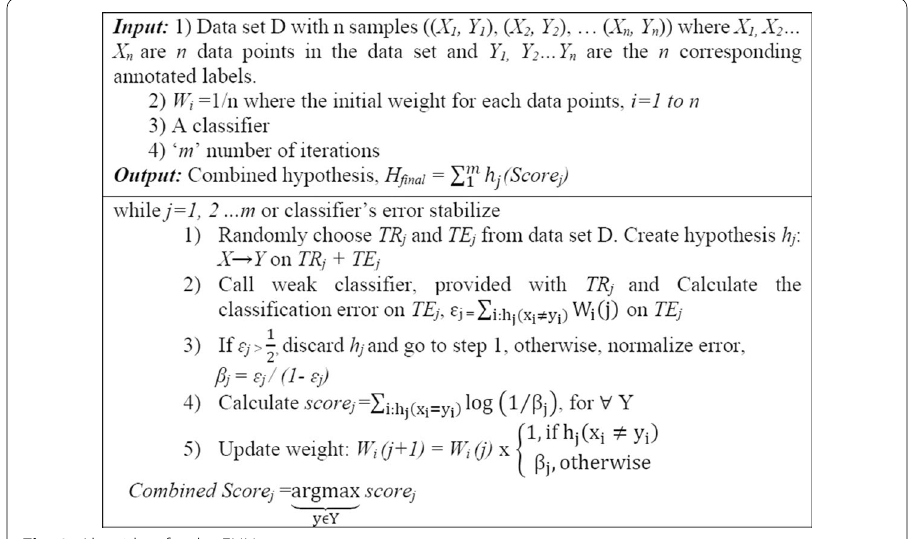
Fig. 2 Algorithm for the